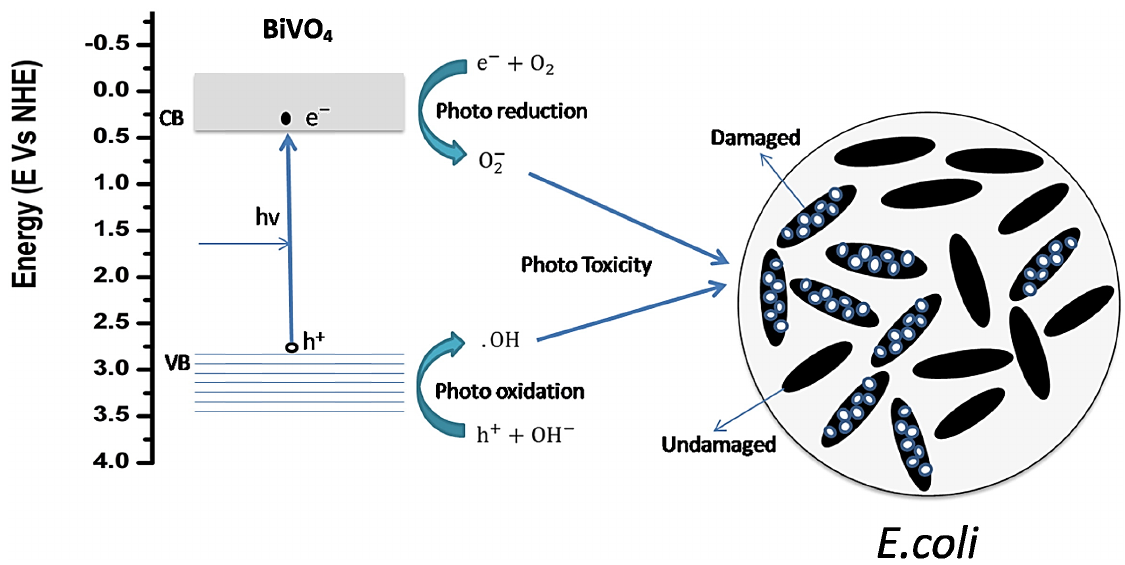
Figure 1. The mechanism of antibacterial effects of monoclinic BiVO 4 nanomaterials against pathogenic bacteria. Adapted from [62] with permission. Copyright 2016 Elsevier.